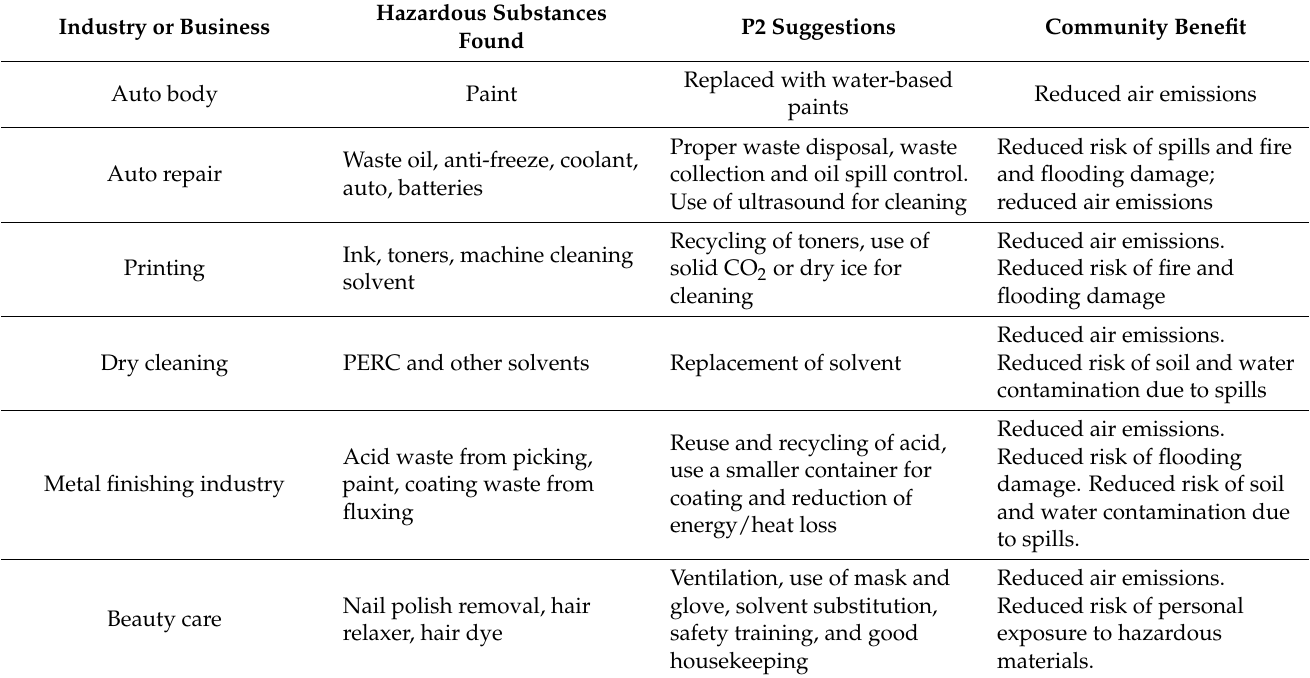
Table 1. Summary of P2